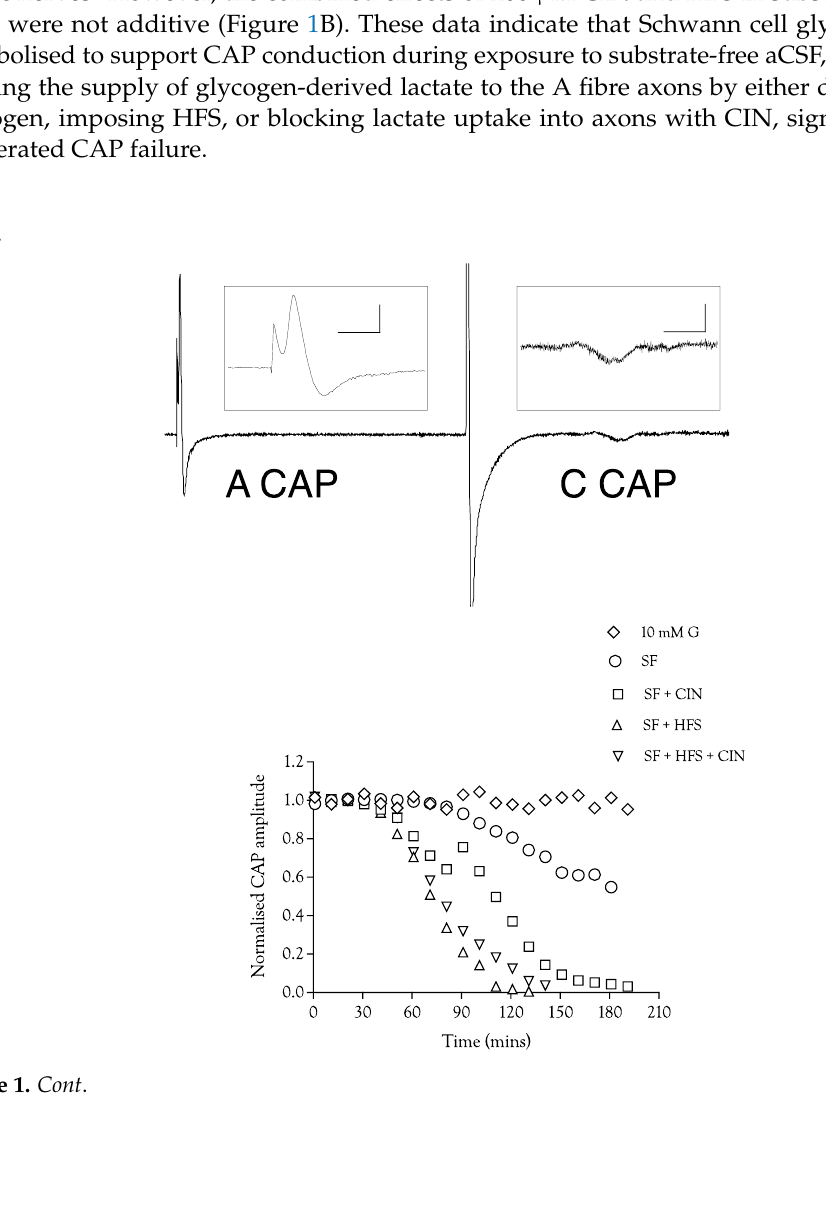
Figure 1. A fibre CAP conduction in substrate-free (SF) aCSF. ( A ). Specimen records of ex vivo sci- atic nerves stimulated electrically, showing the fast-conducting A fibre CAP and the slow-conduct- ing C fibre CAP. Stimulation was adjusted to elicit a maximal A fibre CAP amplitude. The behaviour of the low-amplitude C fibre CAP was not evaluated further. Scale bars are 5 ms and 2 mV for the A fibre CAP and 2 ms and 10 μ V for the C fibre CAP. ( B ). Perfusing sciatic nerves with substrate- free (SF) aCSF resulted in a slow reduction in A fibre CAP amplitude. The speed of failure was accelerated by adding 200 μ M cinnamate (CIN), high-frequency stimulation (HFS), or both. ( C ). In substrate-free conditions, the A fibre CAP was maintained for 94.3 ± 15.1 min ( n = 14), which fell to 51.9 ± 21 min ( n = 4) on addition of CIN, 41.5 ± 8.8 min, ( n = 4) on exposure to high-frequency stim- ulus, and 35.1 ± 5 min ( n = 5) with both CIN and high-frequency stimulus. (G = glucose, L = lactate, HFS = high-frequency stimulus, CIN = cinnemate: applies to all figures; **** = p ≤ 0.0001, ns = not significant). 2.2. Increasing aCSF Glucose Restores the CAP